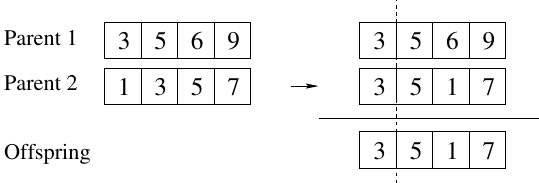
Figure 4. Normalization to preserve feasibility in the example from Figure